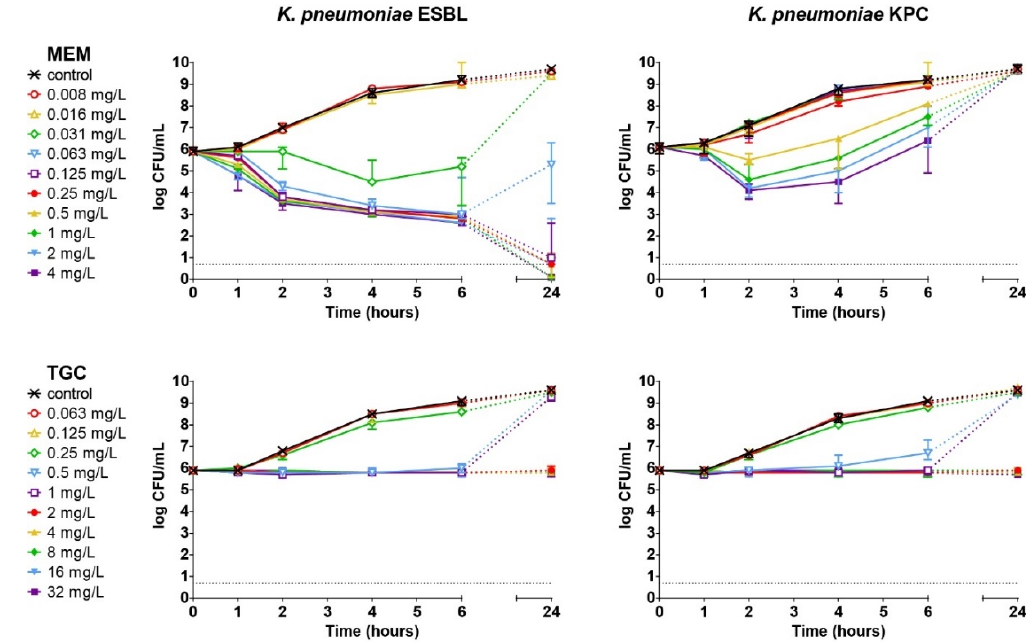
Figure 1. Concentration- and time-dependent bactericidal activity of meropenem (MEM) and tigecycline (TGC) against K. pneumoniae strains. Bacterial cultures of K. pneumoniae ESBL or K. pneumoniae KPC were exposed to two-fold increasing concentrations of antibiotic for 24 h. Shown are the median ± range of in triplicate experiments. The dashed grey line indicates the lower limit of quantification of log 0.7.